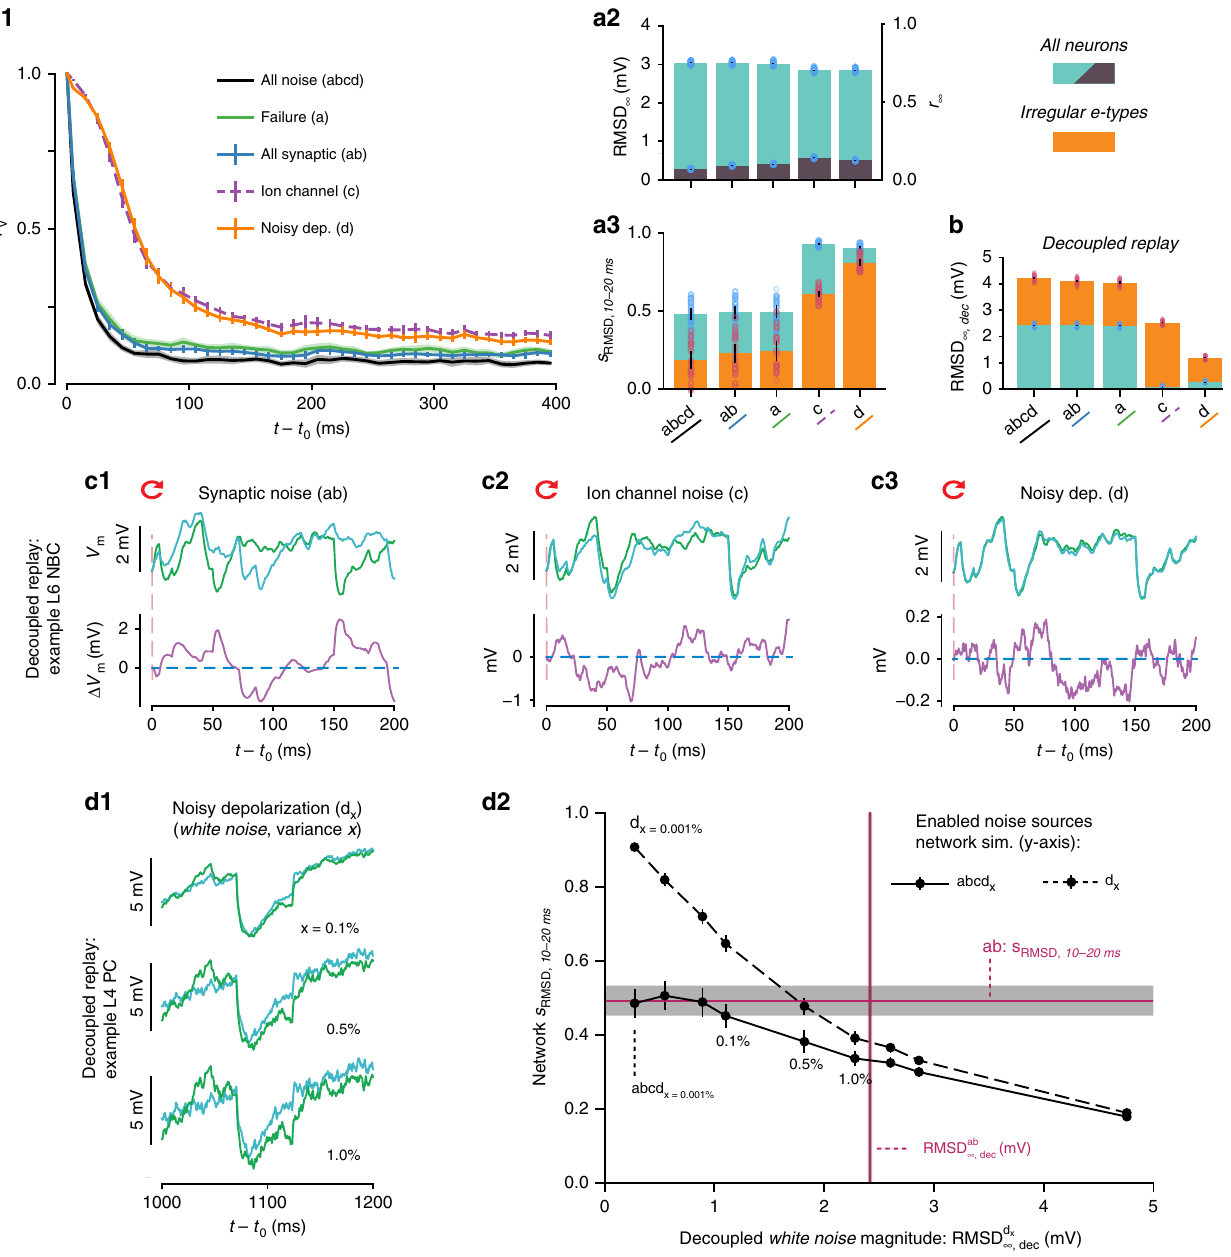
Decoupled white noise magnitude: RMSD ∞ , dec (mV) d x Fig. 4 Synaptic noise dominates divergence. a1 Time-course of correlation r V after resuming at t 0 from identical conditions with different noise sources enabled ( abcd : 40 bases states; a , ab , c , d : 20 base states; mean ± 95% con fi dence interval). a2 Steady-state root-mean square deviation RMSD ∞ (cyan) and correlation r ∞ (purple) with different noise sources enabled. Dots indicate individual trials; black error bars indicate 95% con fi dence interval. a3 Similarity s RMSD at 10 – 20 ms with different noise sources enabled, for all neurons (cyan) and irregular e-types (orange). b Steady-state root-mean square deviation for decoupled simulations, RMSD ∞ ,dec , for all neurons (cyan) and irregular e-types (orange) (20 saved base states). Irregular e-types: 1137 out of 31,346 neurons. c Decoupled replay simulations for a representative L6 NBC neuron, with somatic membrane potential differences between the two trials only due to synaptic noise ( ab ), ion-channel noise ( c ), or a noisy current injection ( d ). d1 The effect of changing random seeds for the noisy depolarization only, for different noise strengths in a decoupled simulation. x : white noise variance as percentage of mean injected current. d2 The decoupled steady-state membrane potential fl uctuations RMSD d x 1 ; evoked by different magnitudes of white noise without network dynamics, vs. the similarity s RMSD at 10 – 20 ms dec during network simulations when either turning on only the white noise depolarization ( d ) or all noise sources ( abcd ). Similarly, in purple, RMSD ab 1 ; for dec synaptic noise vs. the similarity at 10 – 20 ms when only turning on synaptic noise ( ab ). All error bars and shaded areas indicate 95% con fi dence intervals. Means for d2 are based on ten base